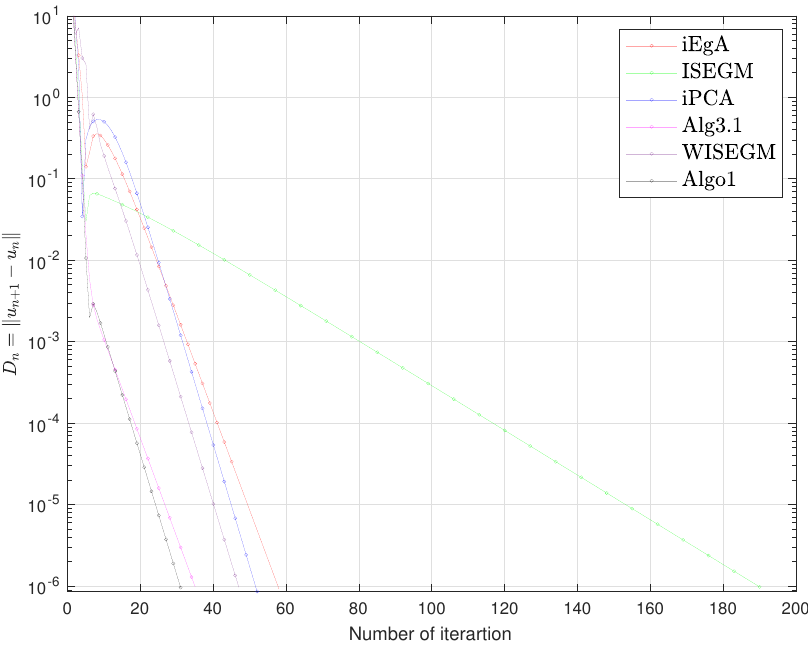
Figure 8. Example 3: Elapsed time are 2.94, 19.59, 2.73, 3.83, 4.76, 3.04